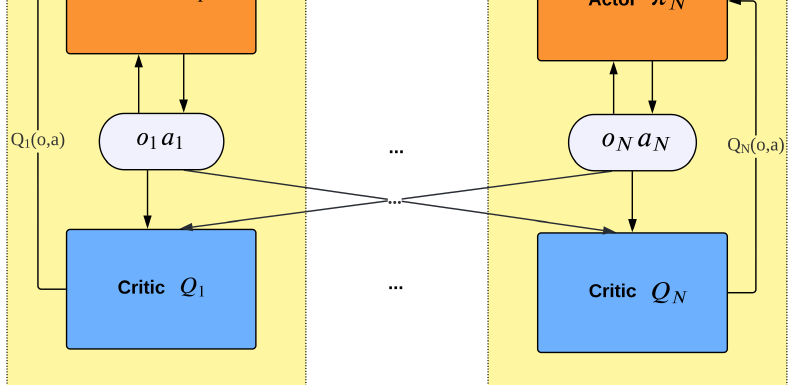
Figure 2. Overall architecture of DDPG.